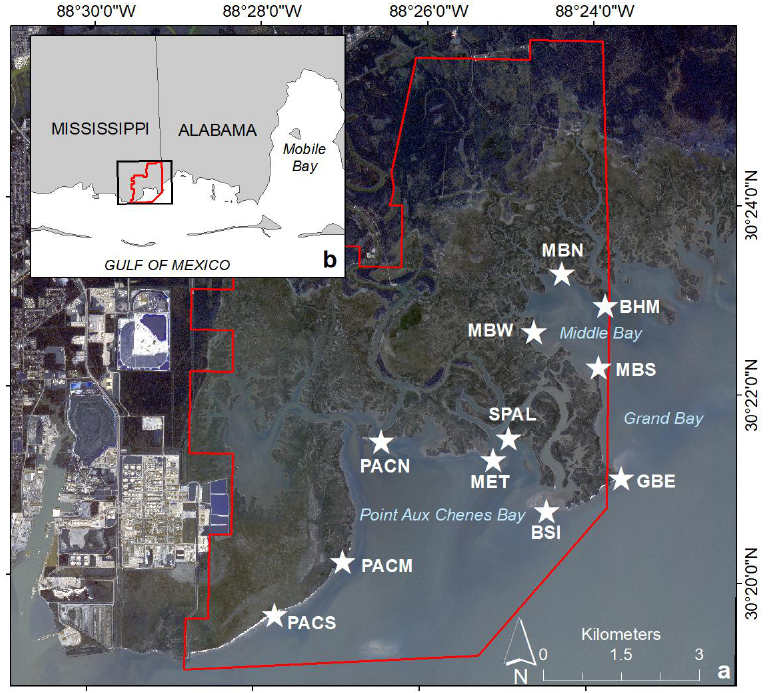
Figure 1. Map of the Grand Bay National Estuarine Research Reserve (red boundary line) with white stars depicting the location of shoreline erosion study sites (a). The inset map (b) shows the location of the study region on the border of Mississippi and Alabama, USA, in the northern Gulf of Mexico. Sites names refer to: BHM = Bayou Heron Mouth; MBN, MBW, MBS = Middle Bay North, West, and South, respectively; GBE = Grand Batture East; BSI = Bird Island; SPAL = North Jose Bay; MET = Met Station Island; PACN, PACM, PACS = Point aux Chenes North, Middle, and South, respectively. Data sources: Shoreline from © OpenStreetMap contributors (https://www.openstreetmap.org/ accessed on 30 October 2018). Image basemap from © Maxar Table 1. Site location, vegetation, elevation, and sedimentary characteristics for the eleven Grand Bay National Estuarine Research Reserve shoreline erosion study sites. X coordi- Site 1 nate 2